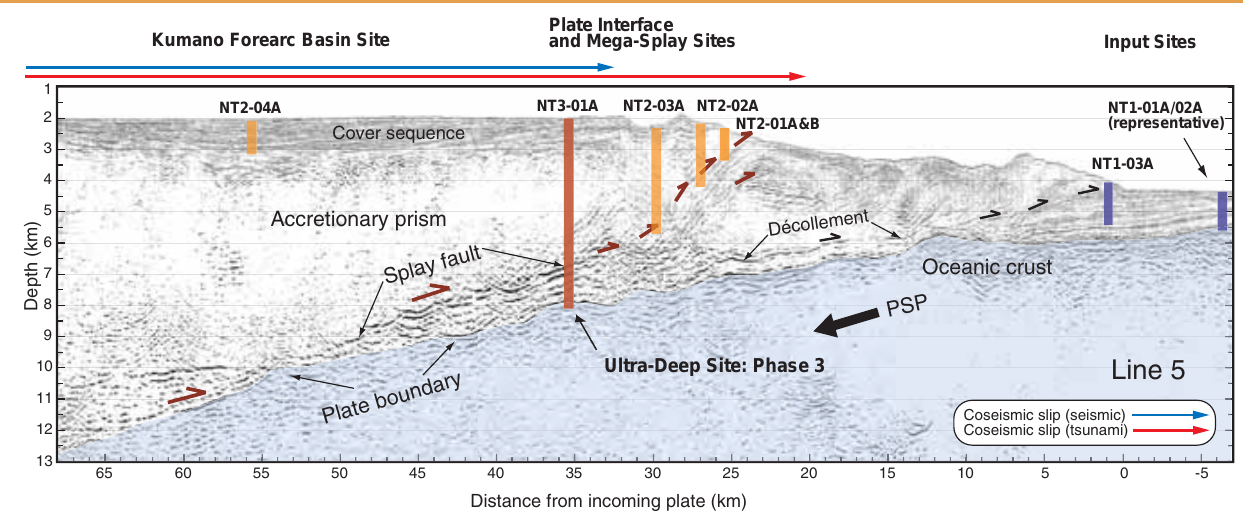
Figure 2. Pre-stack depth migrated seismic line of Park et al. (2002), with locations of planned drill